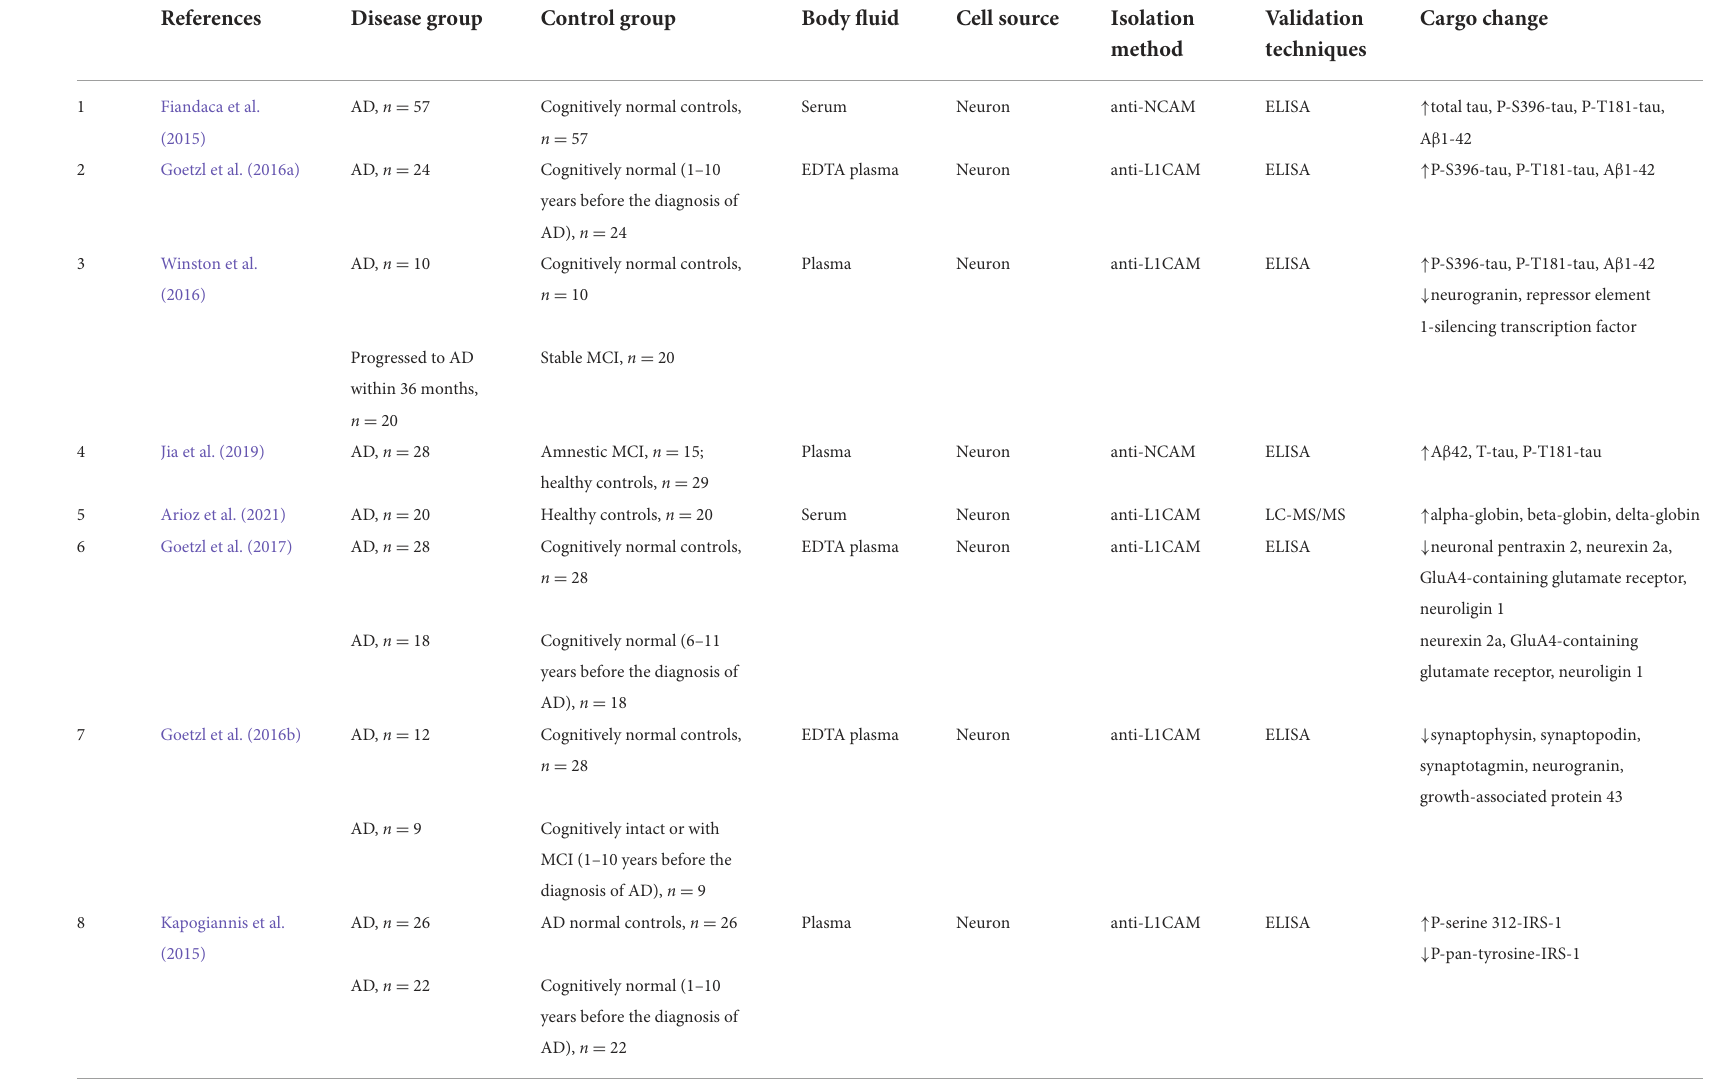
TABLE 1 Exosomes derived from human neuron and astrocyte cells as AD biomarkers in previous